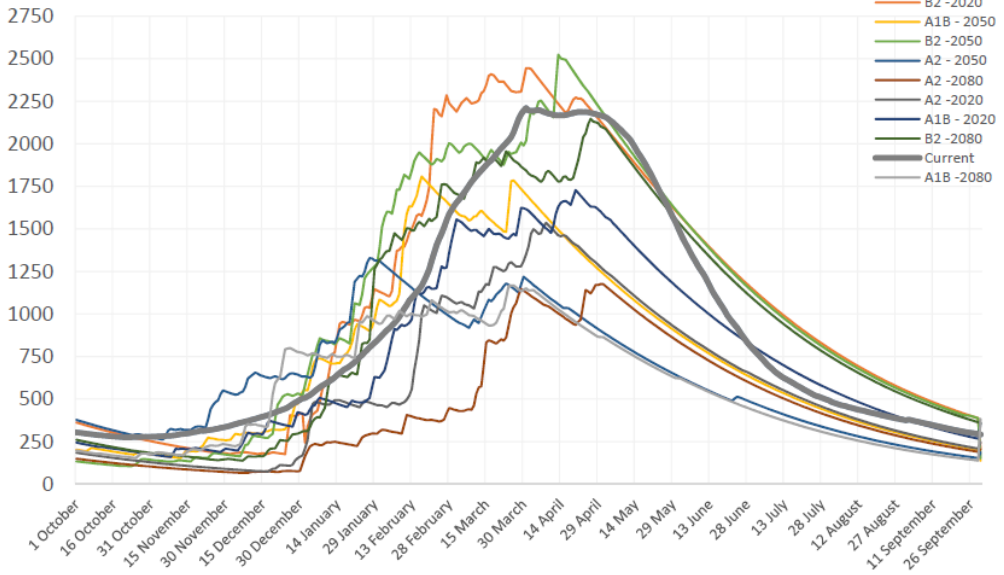
Table 7. Monthly flow changes in Zambezi River at Victoria Falls. All figures in % of flow in the reference period 1961–1990. Emission scenarios A2, A1B and B2.